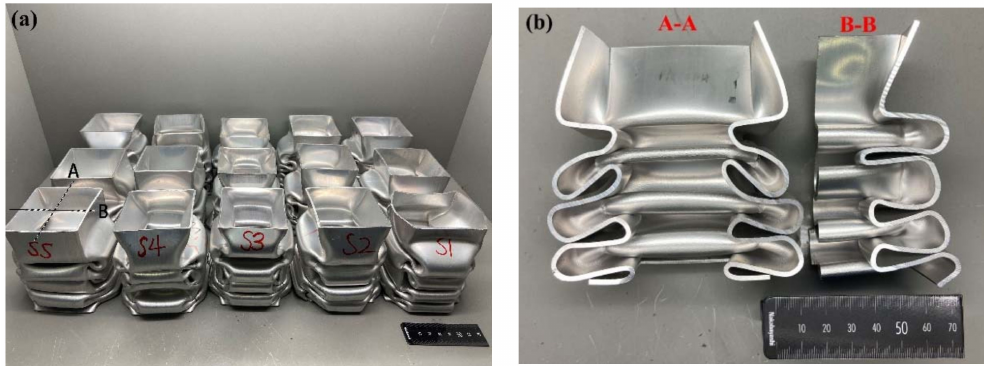
Figure 3. Photographs of ( a ) samples after crushing test, ( b ) section diagram of